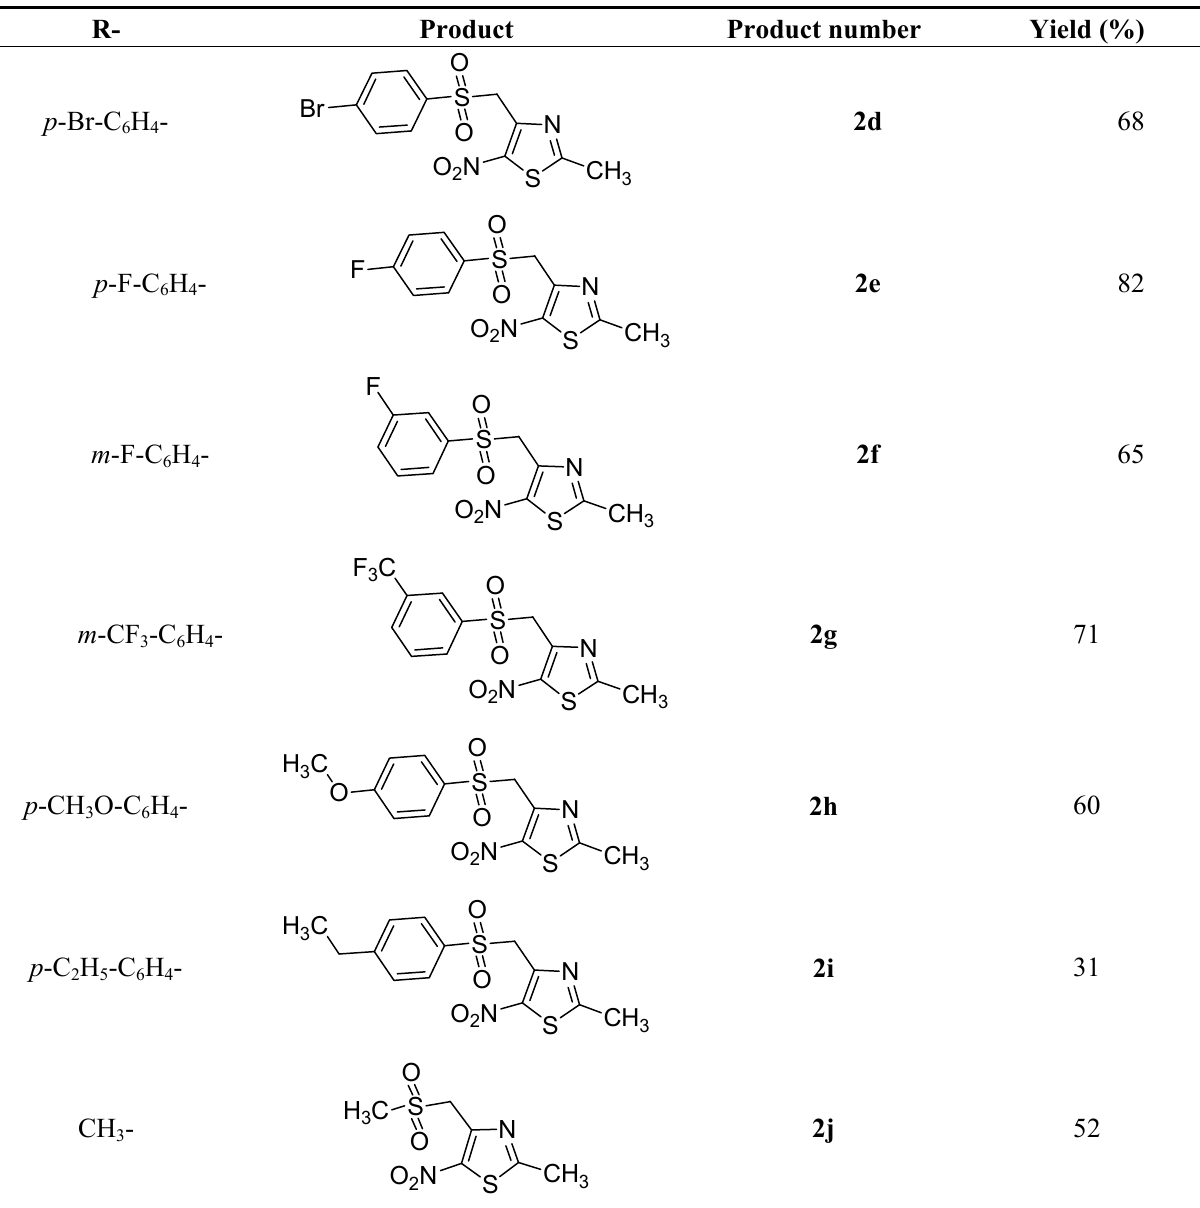
2. Microwave mediated preparation of several sulfones derivatives of R- Product Product number Yield